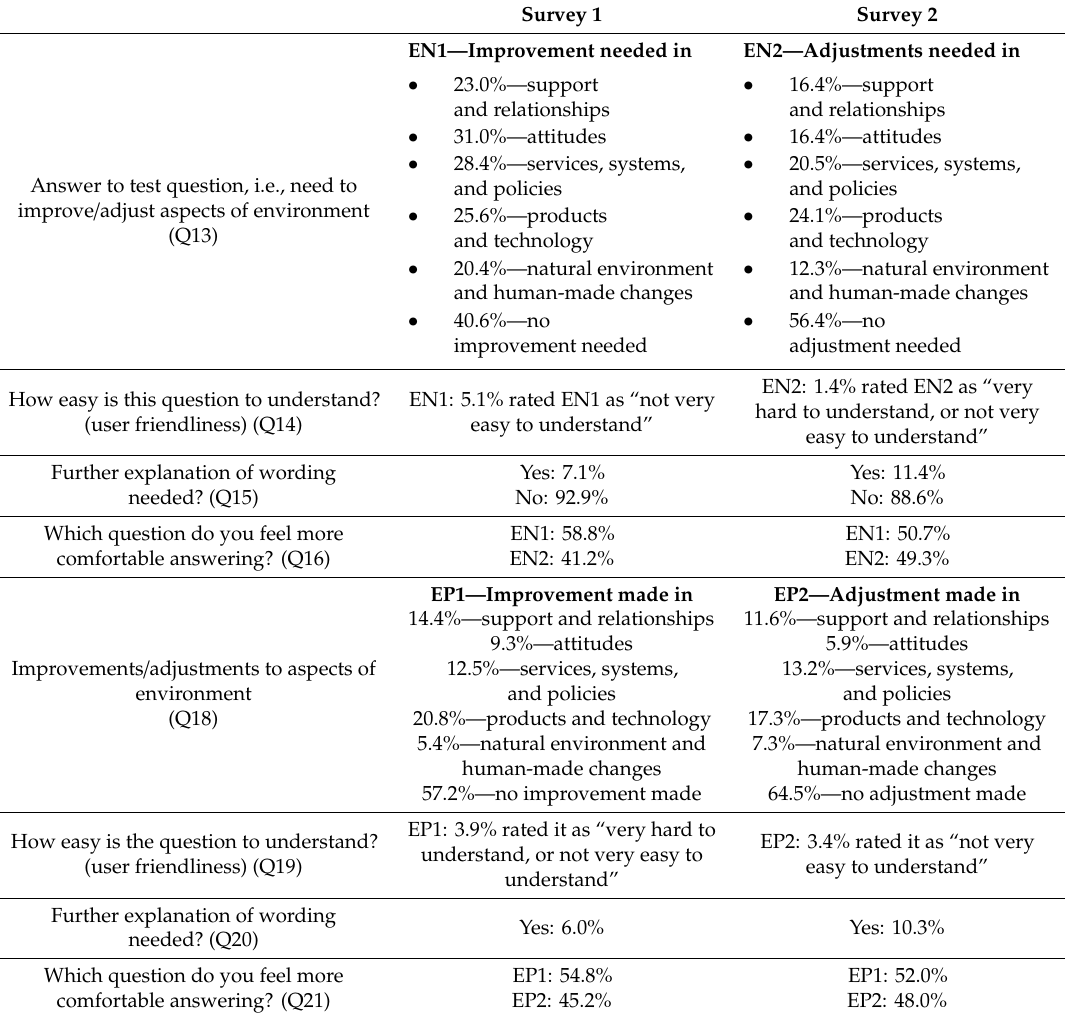
Table 7. Responses to environment questions. Survey 1 Survey